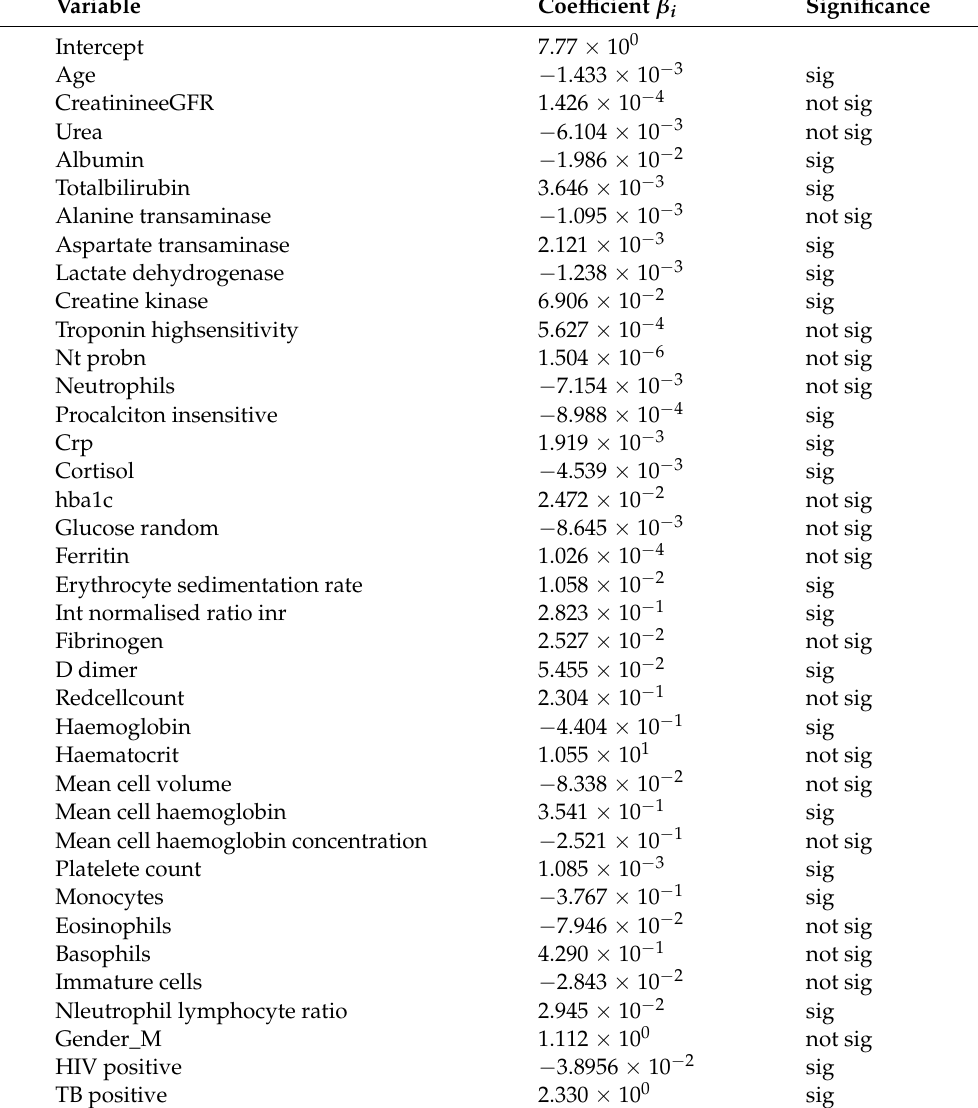
Table 5. Summary of the results of the logistic regression model for risk stratification.